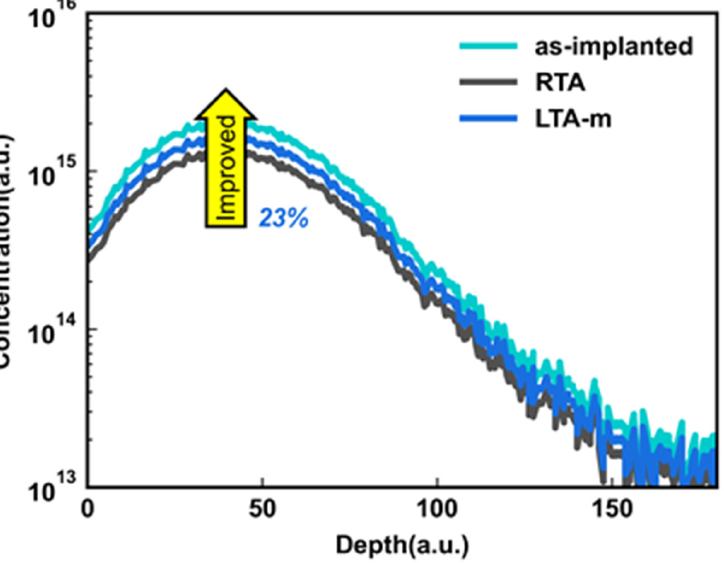
Figure 3. Measured boron concentration after ion implantation as implanted SIMS. Simulated the boron concentration of subsequent activation with RTA and LTA-m by Sentaurus TCAD.